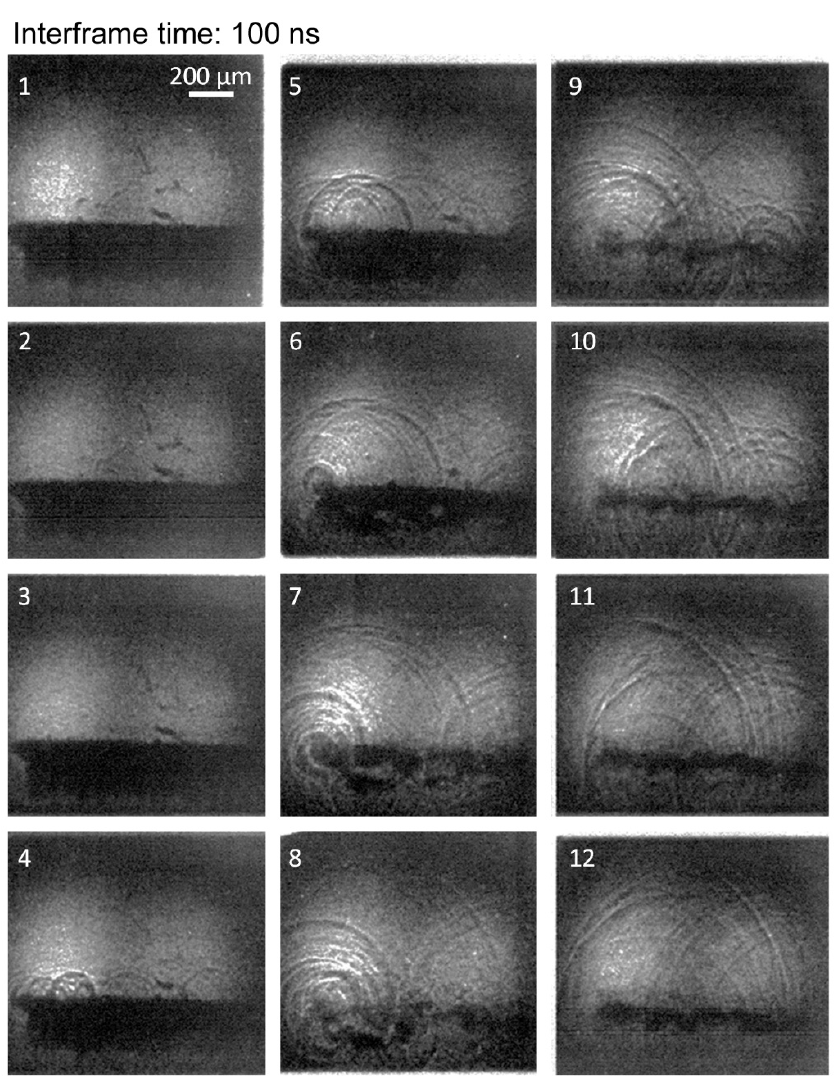
Figure 8. High-speed video imaging of the formation of multiple shock waves at the collapse of a large toroidal bubble. The series of photos are numbered 1 to 12 over time. This collapse type is classified to the toroidal bubble. Camera settings are: 10 million frames/s, and 5 ns exposure time. The scale bar is 200 µm.